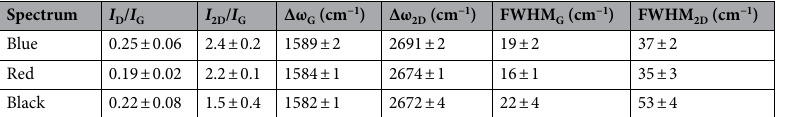
Table 1. Characteristics of the Raman spectra shown in Fig.